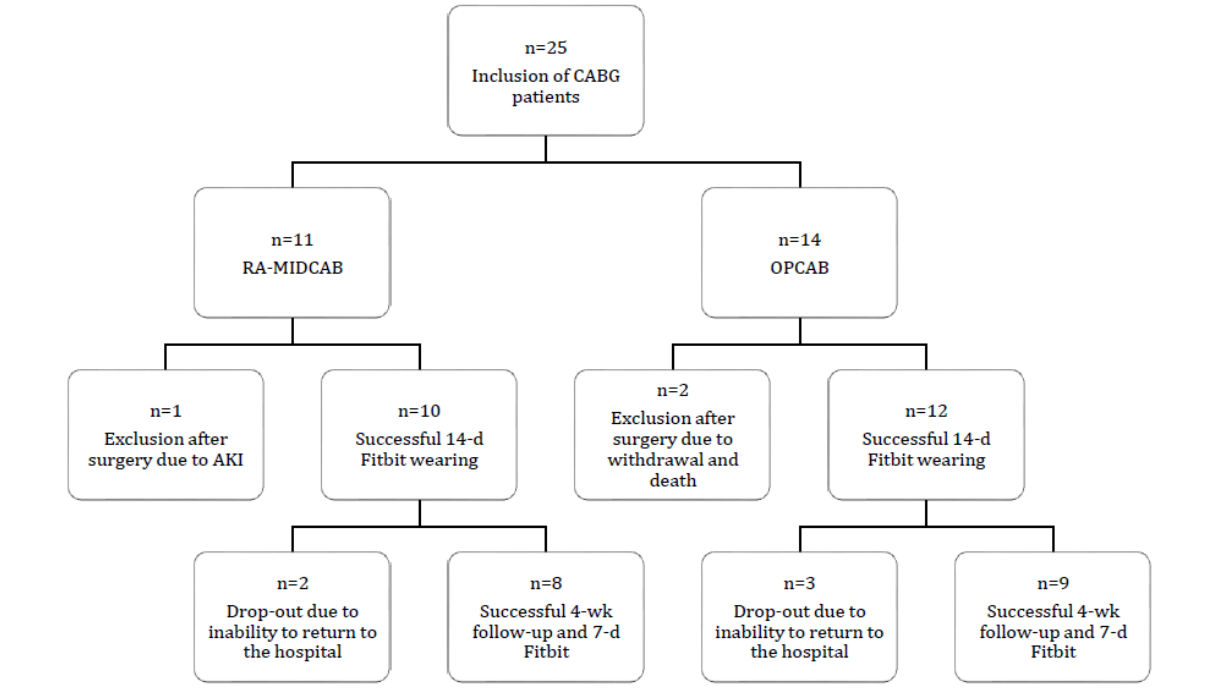
Figure 2. Study flowchart. CABG: coronary artery bypass graft; RA-MIDCAB: robotically assisted minimally invasive direct coronary artery bypass; OPCAB: off-pump coronary artery bypass; AKI: acute kidney